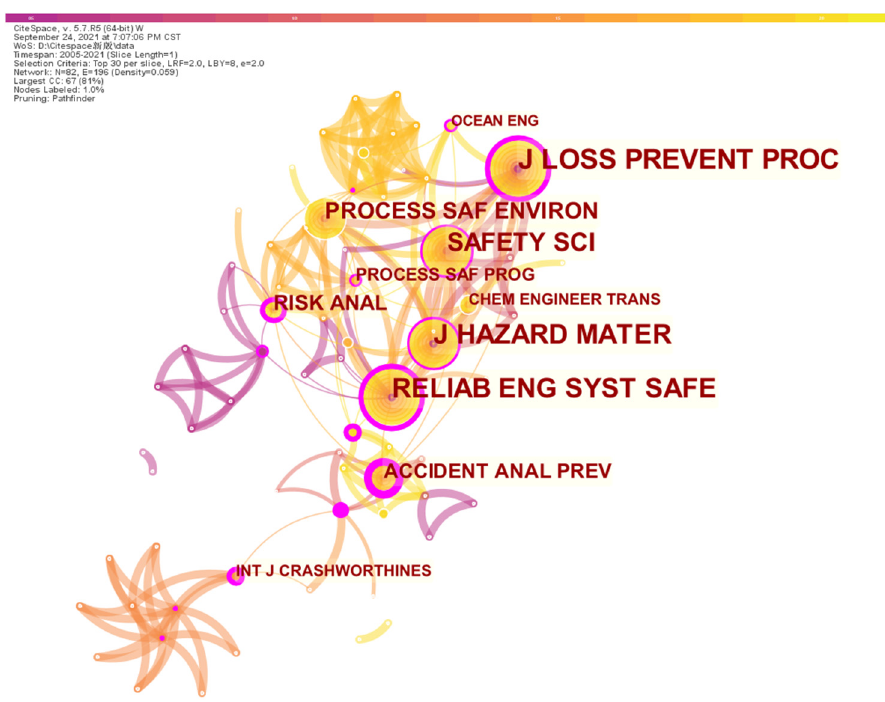
Figure 8. Number of publications by journal.